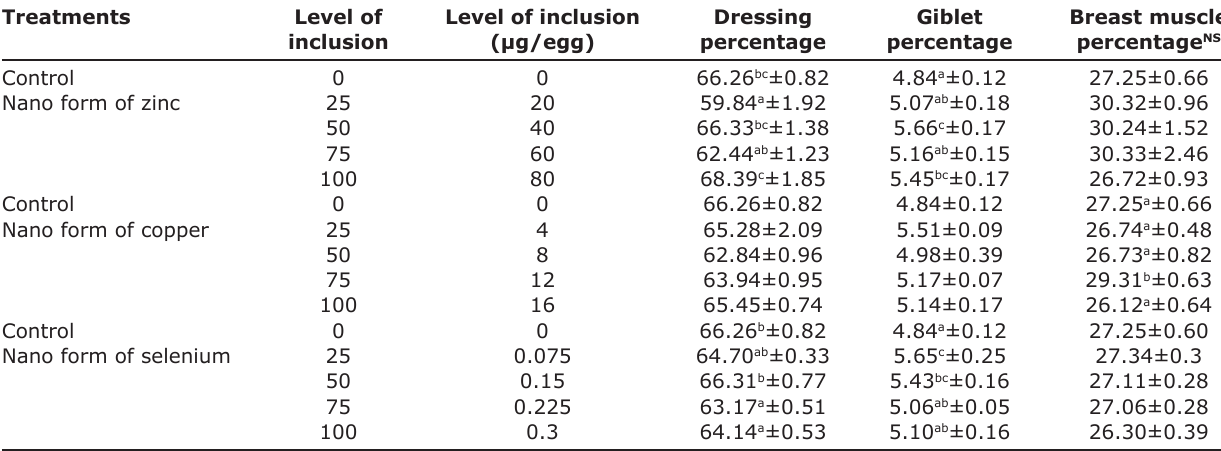
Table-6: Effect of in ovo feeding of broiler eggs with nano form of zinc, copper and selenium at graded levels on dressing, giblet and breast muscle percentage of broilers (0-5 weeks)*. Treatments Level of